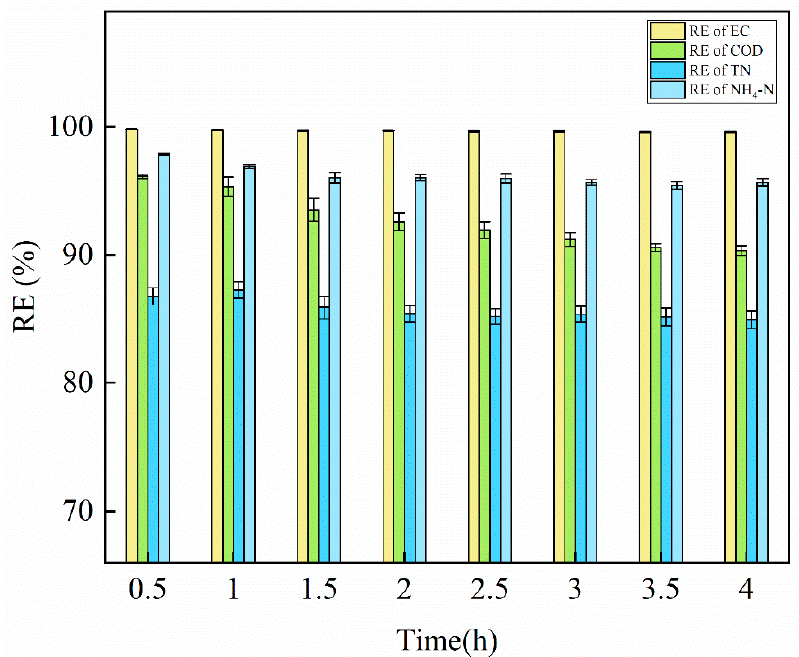
Figure 2. The RE (removal efficiency) of the EC, COD, TN, and NH 4